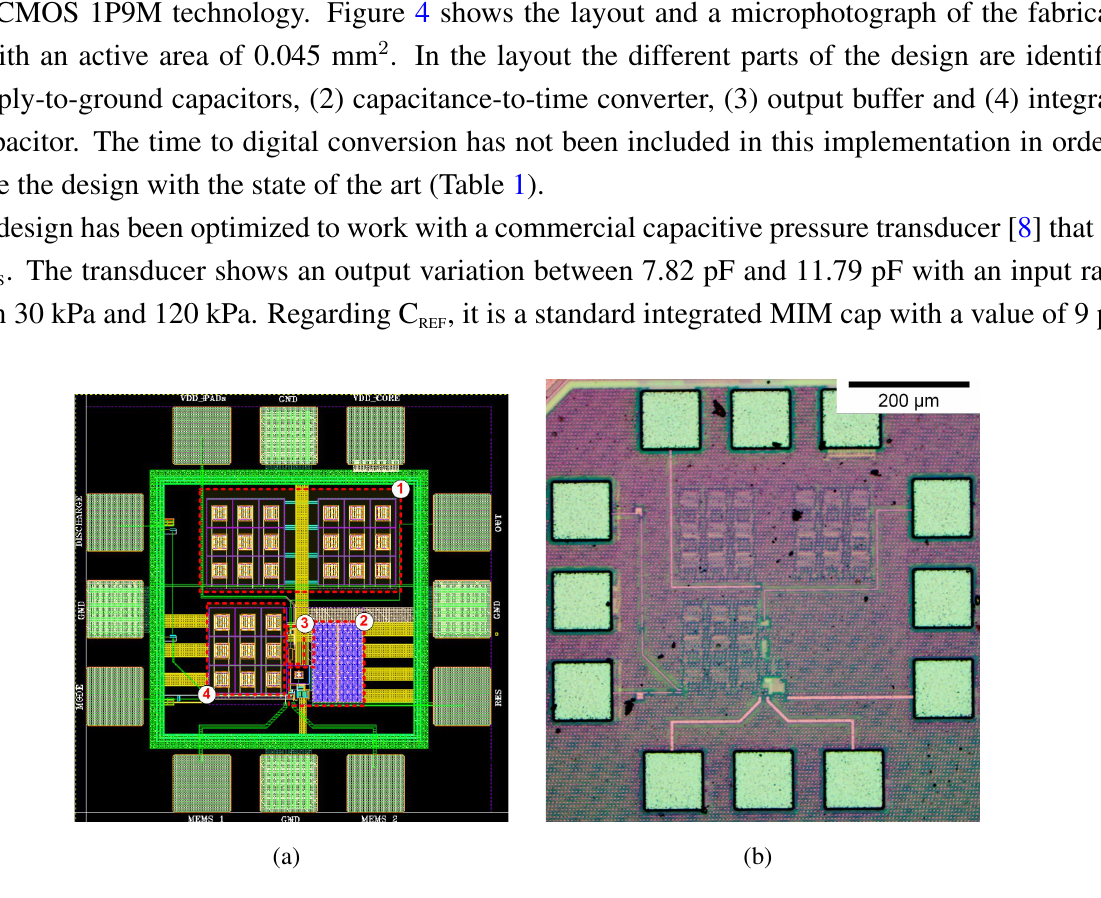
Figure 4. ( a ) Layout plot and ( b ) photograph of the